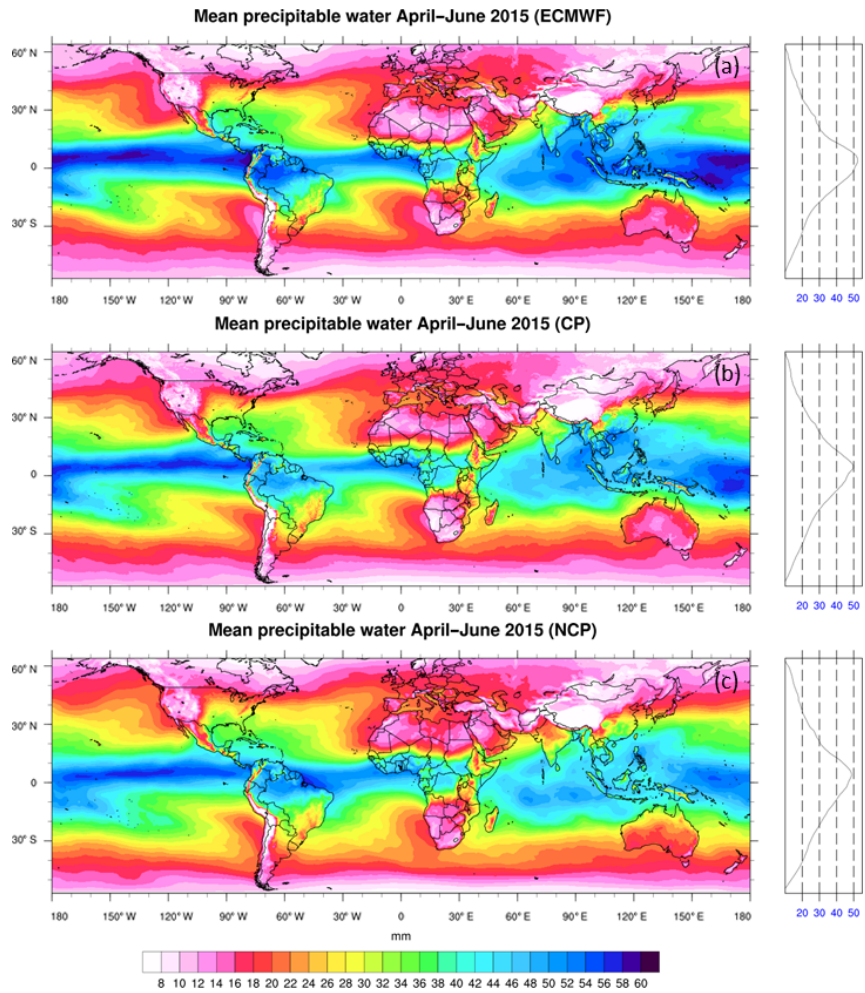
Figure 9. Mean precipitable water (PW) (mm) averaged between April and June 2015. (a) shows the operational ECMWF analysis, (b) the CP simulation, and (c) the NCP simulation. Data are averaged in 6h intervals to match the ECMWF analysis times. On the right, the zonal mean is shown.